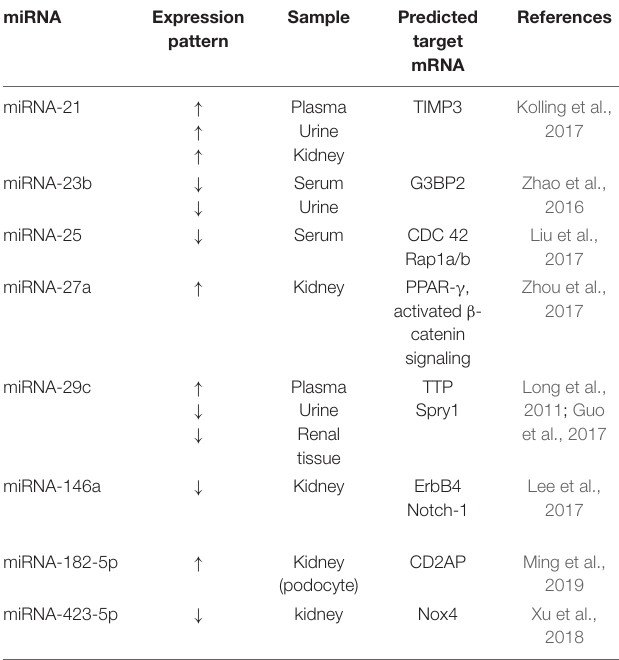
TABLE 2 | Associations between podocyte injury and miRNA expression levels in blood, urine, and kidney in patients with diabetic nephropathy. miRNA Expression pattern